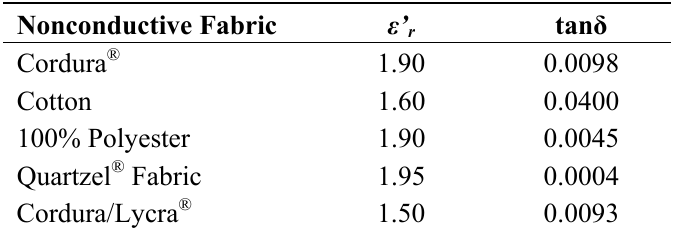
Table 1. Dielectric Properties of normal fabrics tested in